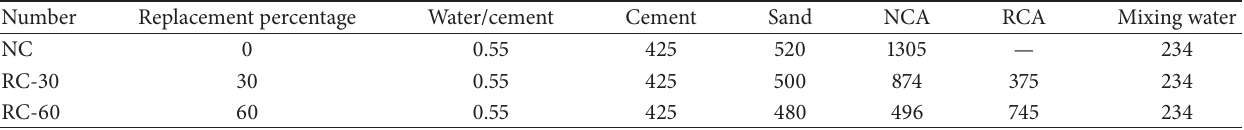
Table 2: Mix proportions of concretes (kg/m 3 ).